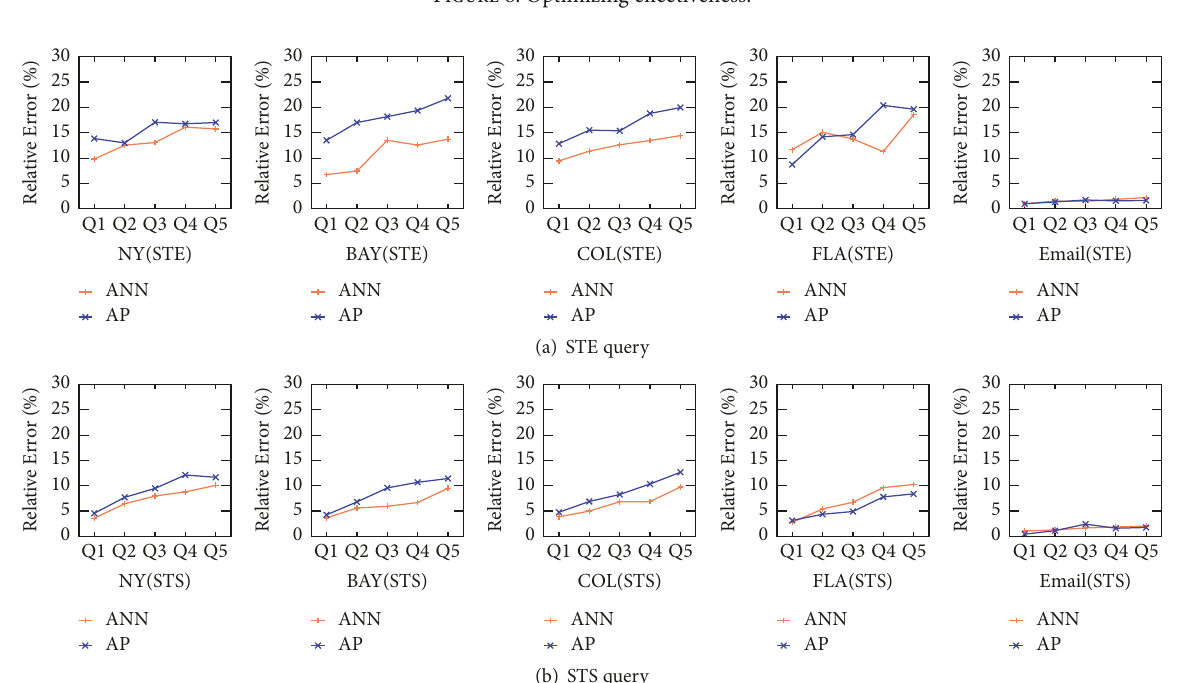
Figure 8: Optimizing effectiveness.